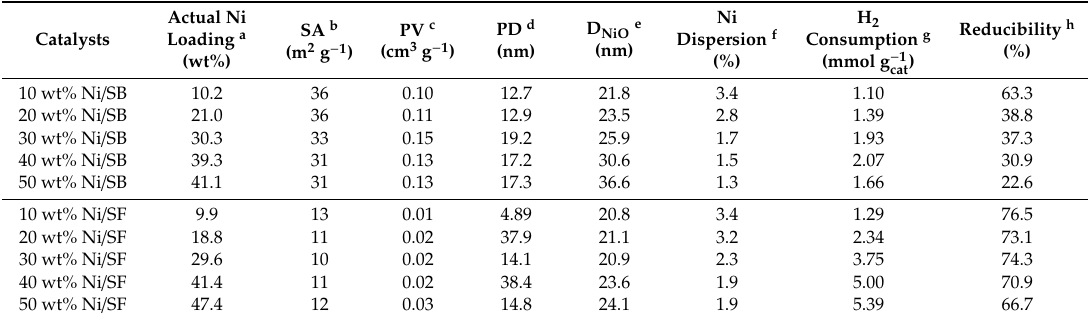
Table 2. Textural properties, NiO crystallite size, Ni dispersion, H 2 consumption and reducibility of Ni / SB and Ni / SF